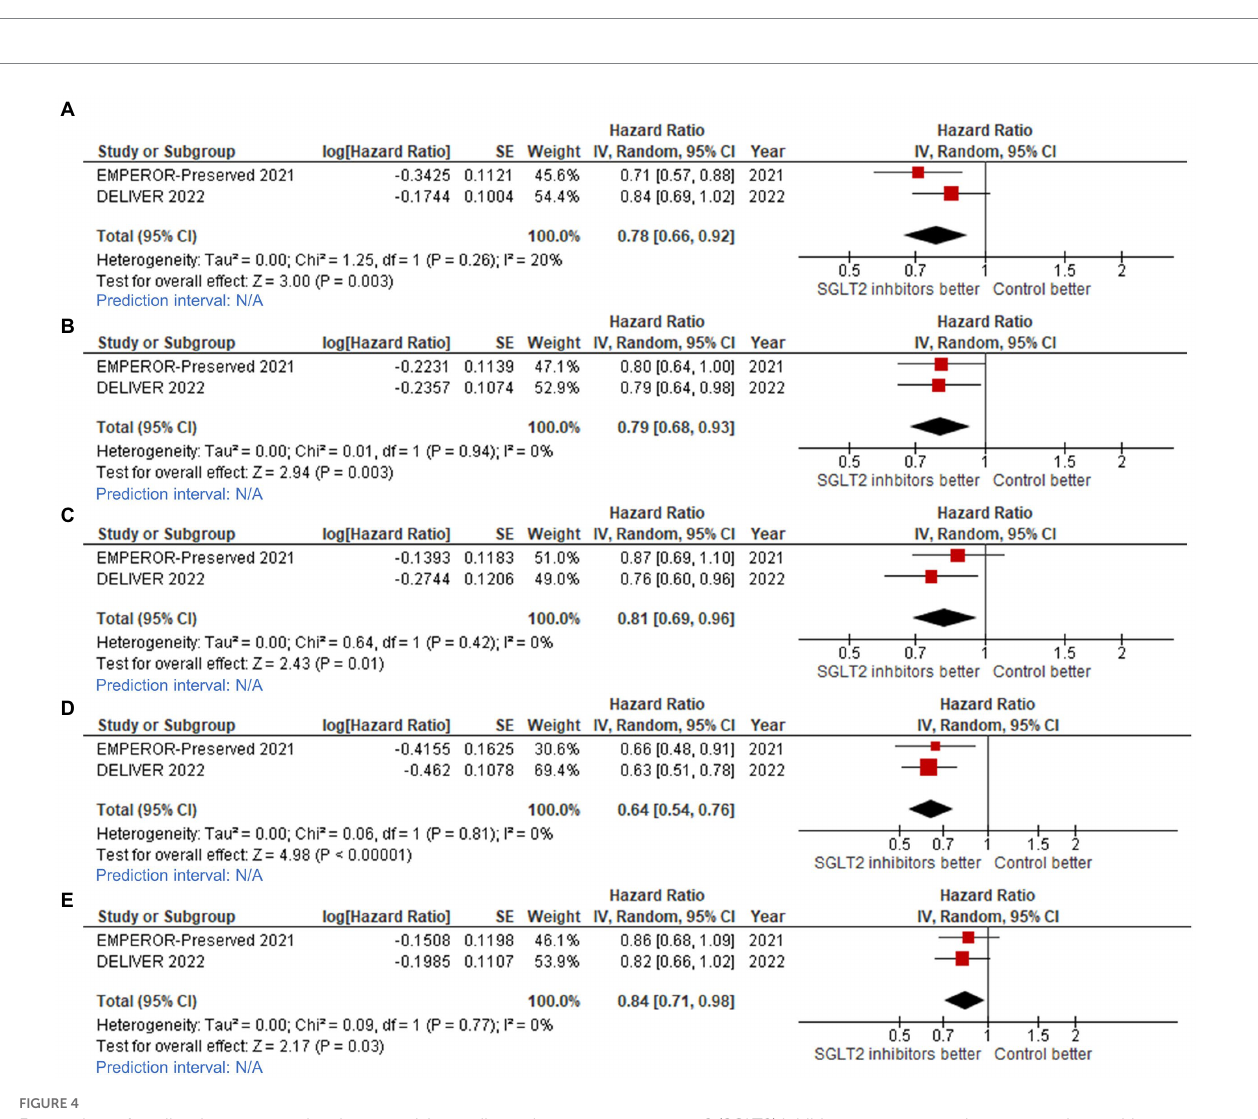
FIGURE 4 Forest plots of studies that compared patients receiving sodium-glucose cotransporter-2 (SGLT2) inhibitors versus controls among patients with (A) ejection fraction (EF) 40–50% in cardiovascular (CV) death/hospitalization for heart failure (HHF) outcome; (B) EF 50–60% in CV death/HHF outcome; (C) EF >60% in CV death/HHF outcome; (D) EF 50–60% in total HHF outcome; and, (E) EF >60% in total HHF